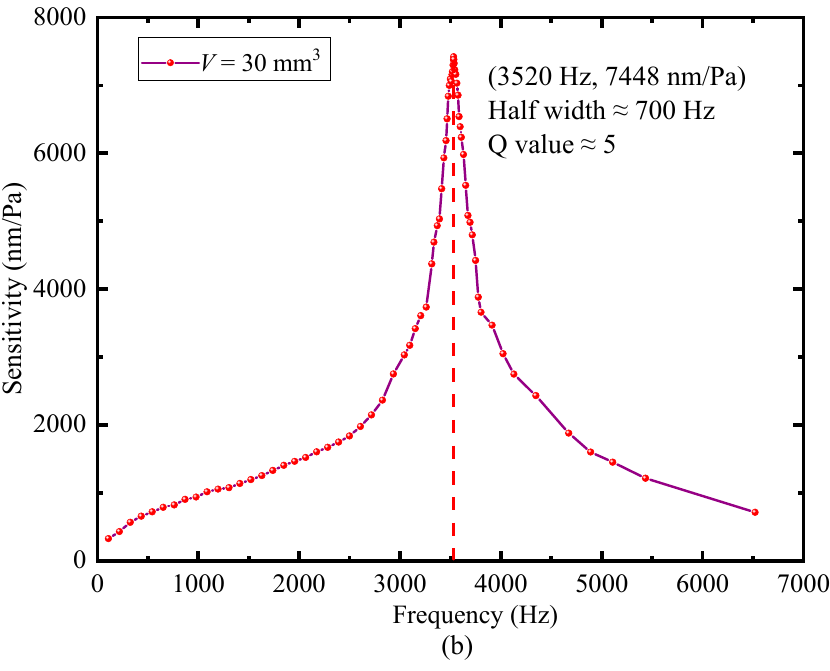
Figure 8. The FOM experimental frequency response curve of the different cavity volumes; ( a ) 12 mm 3 ; ( b ) 30 mm 3 . Table 1. Comparison of FOMs of different cavities with the same cantilever size. Cavity